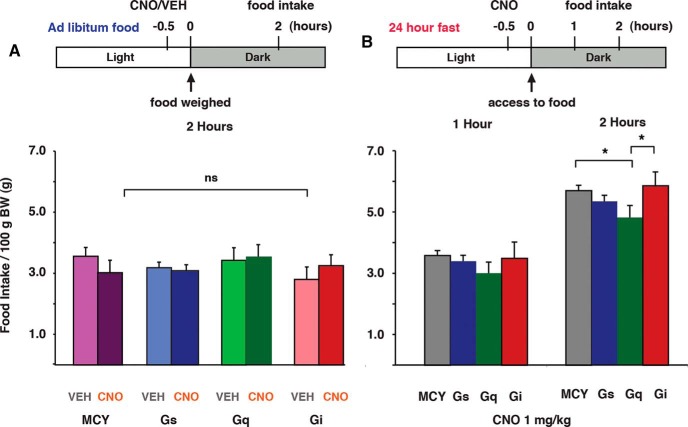
Impact of CIN activity modulation on food intake after free food access and a 24-h fast. A, MCY, Gs, Gq, and Gi NAc-CIN–expressing mice with ad libitum food access were given an injection of either VEH or CNO 30 min before the dark cycle (active phase), and food consumption was measured 150 min later. B, CNO injections 30 min before the active phase in mice fasted for 24 h resulted in a significant reduction in food intake for Gq-expressing compared with both MCY- and Gi-expressing mice at 2 h after reintroducing home-cage food. Gq, n = 10; Gs, n = 14; Gi, n = 10; MCY, n = 15. *, p < 0.05.